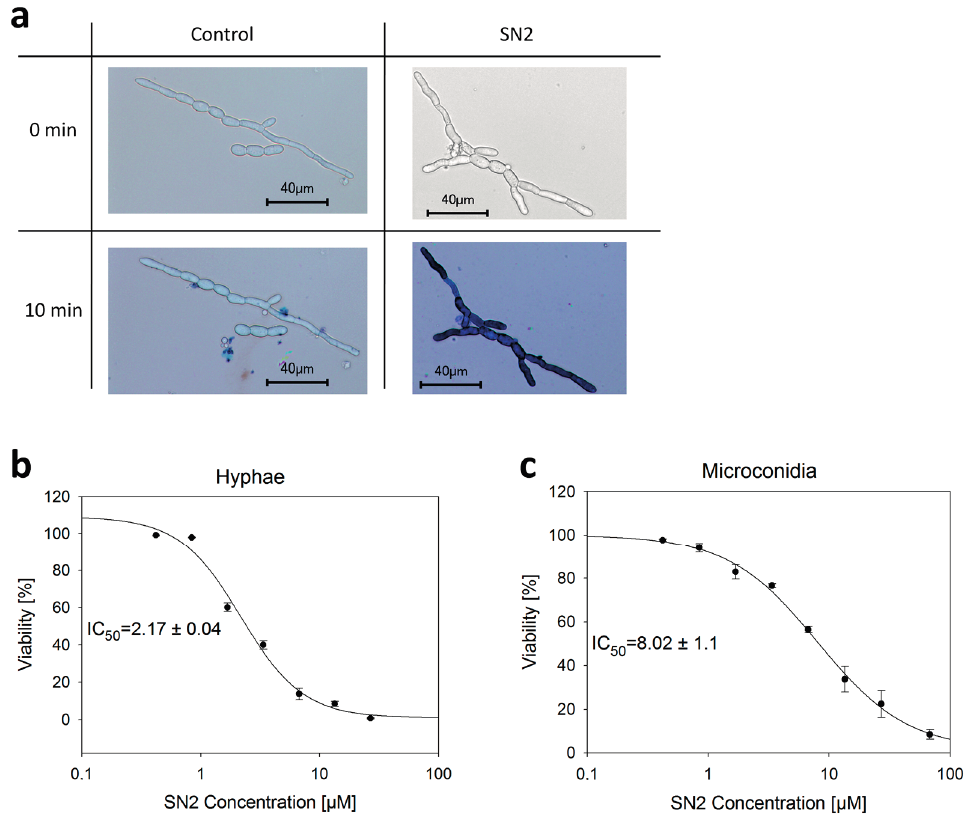
Figure 4. Trypan blue assay. ( a ) Perforating effect of SN2 on the biomembrane of F. solani . The control shows no stained cells whereas SN2-treated cells are stained dark blue after the addition of the trypan blue dye. Pictures were taken with the microscope software (Keyence BZ-9000 Viewer); ( b , c ) Analysis of the viability of hyphae and microconidia of F. solani by performing the trypan blue assay with several concentrations of SN2. IC 50 values were determined using a four-parametric logistic curve (Sigma Plot